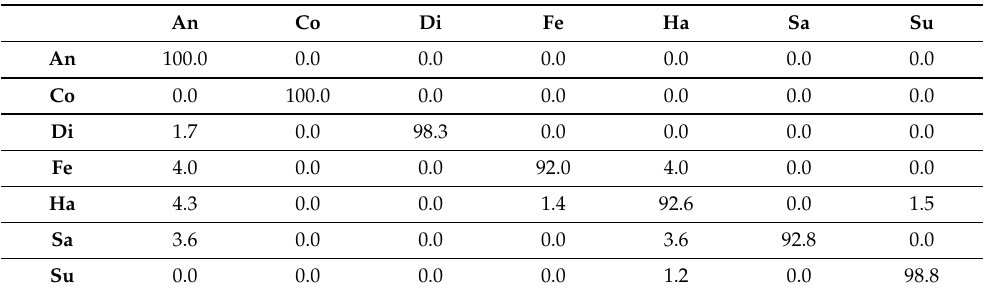
Table 7. Confusion matrix: SVM-based facial displacement (CK+) from displacement, intensity and